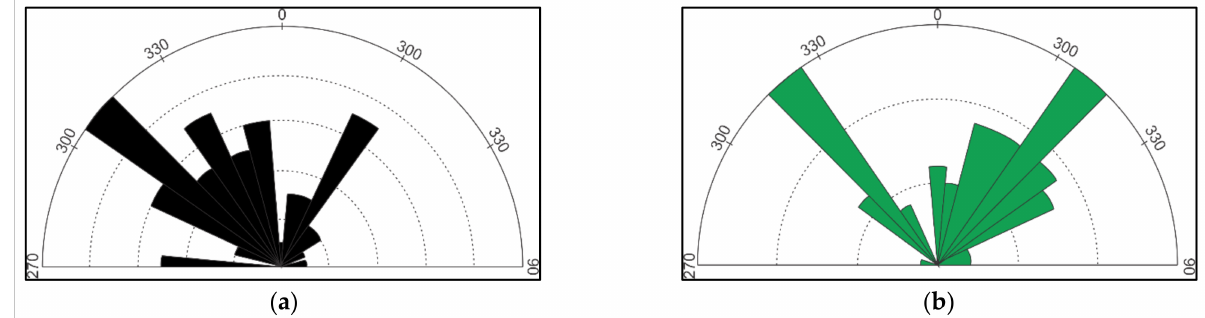
Figure 8. Comparison of the rose diagrams between ( a ) Topographic lineament traced; ( b ) THD residual anomaly